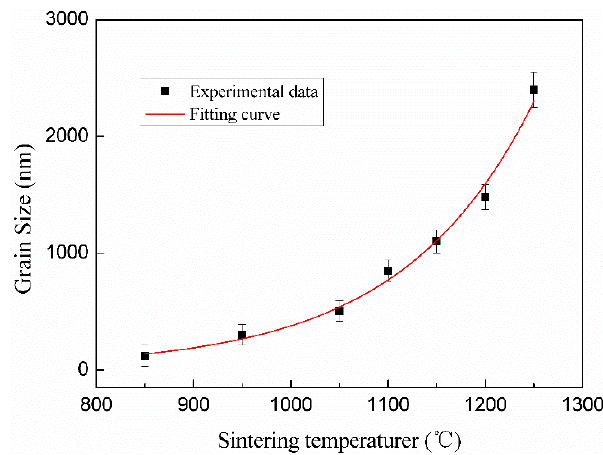
Figure 8. Grain size variation curve of pure HA prepared with different sintering temperatures for 2 h.